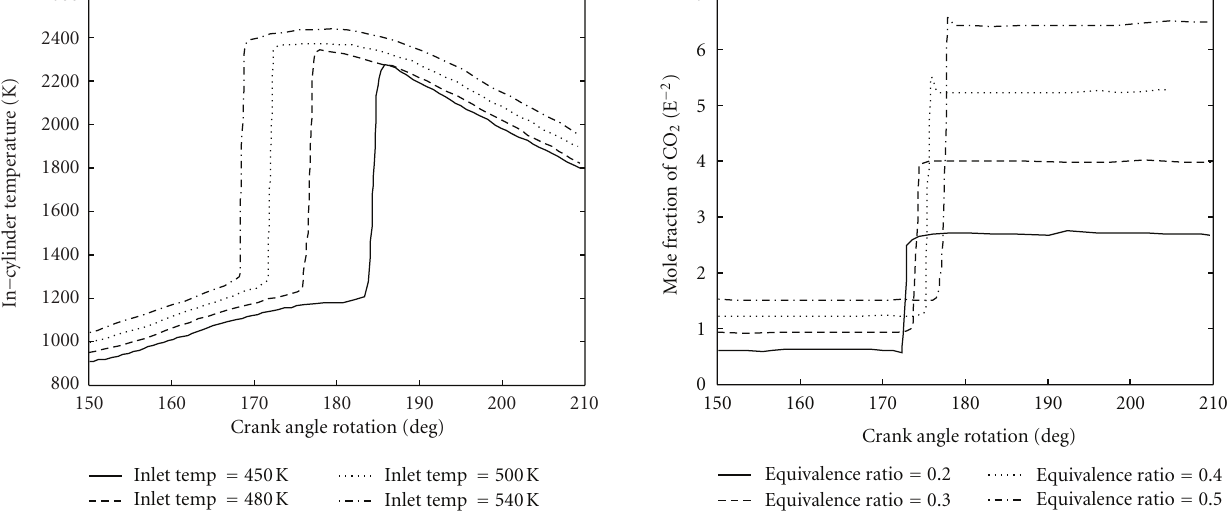
Figure 13: E ff ect of equivalence ratio variations on in-cylinder CO 2 concentration.